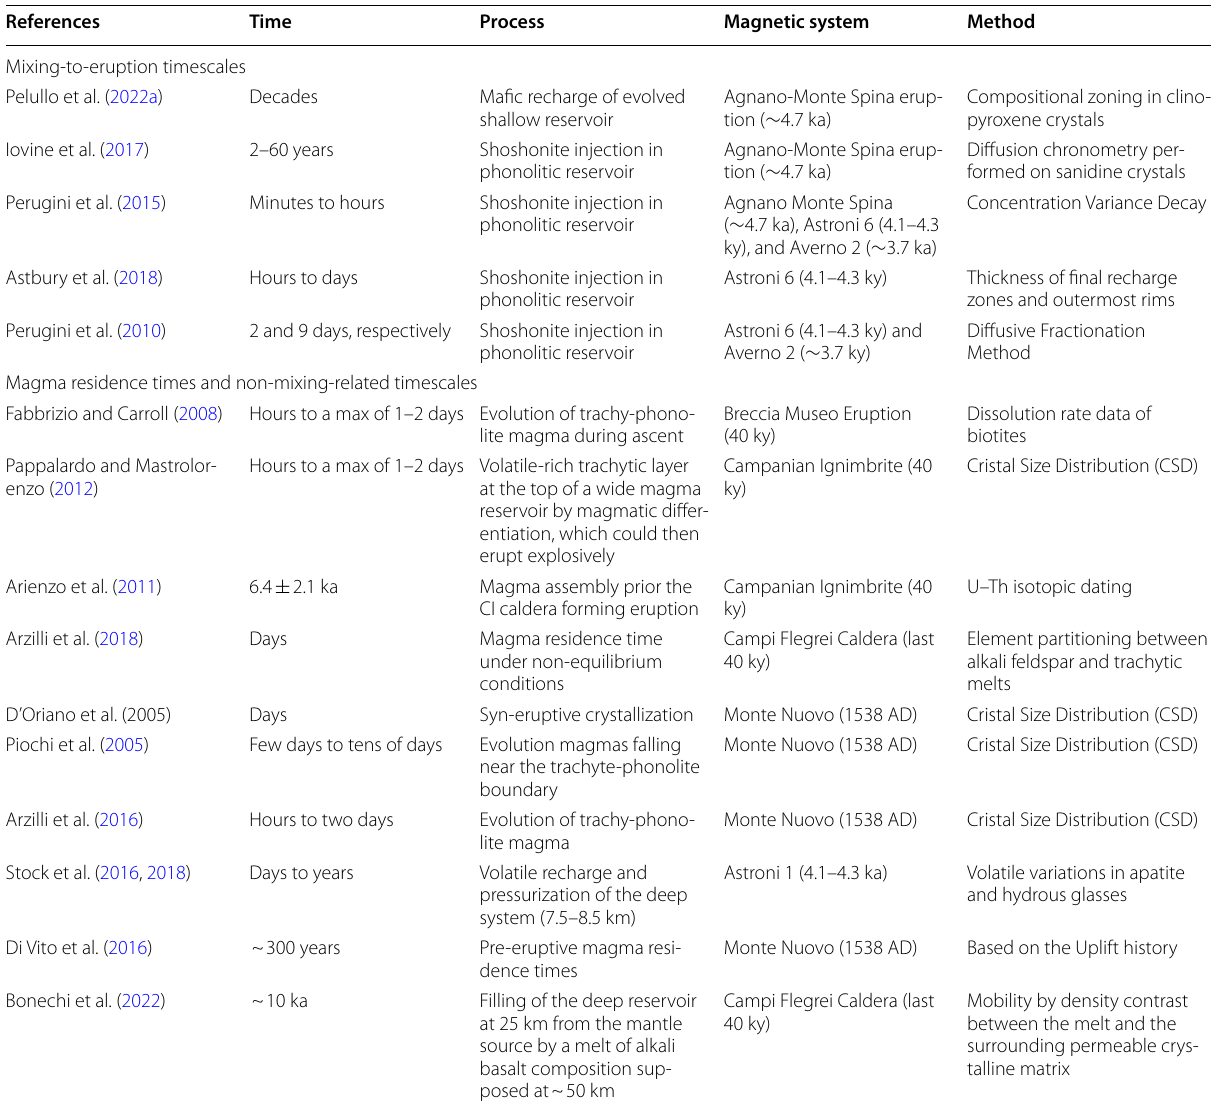
Table 2 Résumé of the latest studies regarding ascent mechanisms and